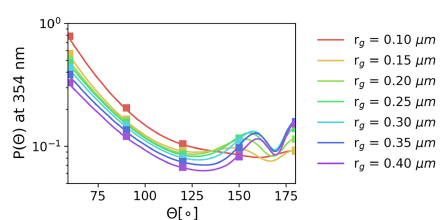
Figure A1. Phase function P((cid:50)) at 354nm of the parameterized Mie-scattering aerosol in sensitivity studies as a function of r g (with n r = 1 . 5 and n i = 0 . 06). The markers in the plot correspond to val- ues when (cid:50) = 60, 90, 120, 150, 180 ◦ .